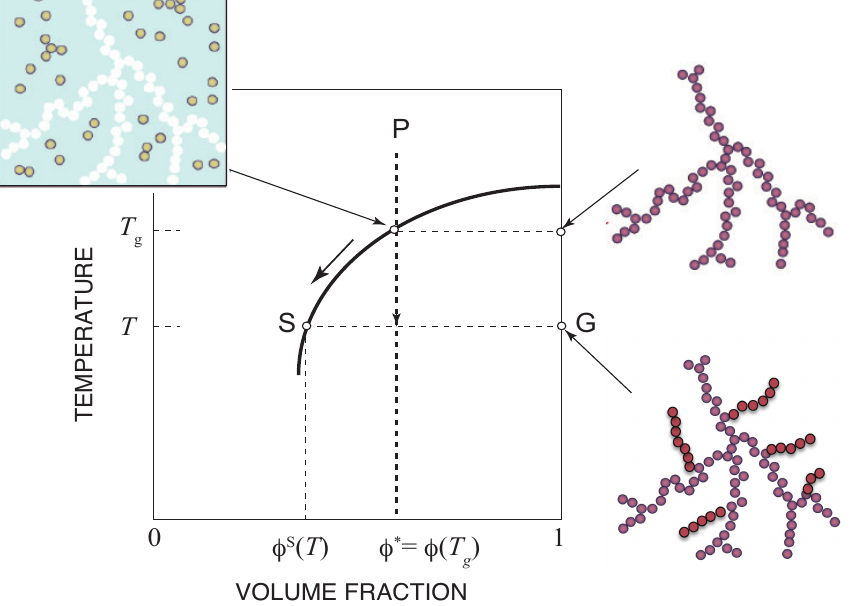
Figure 3. Sol–gel equilibrium in Stockmayer’s post-gel treatment shown on the temperature– concentration plane. The entire solution contains the sol part (S) and the gel part (G) in equilibrium in a spatially homogeneous state. By cooling, the concentration of the sol remains at the critical value so that it moves along the sol–gel transition